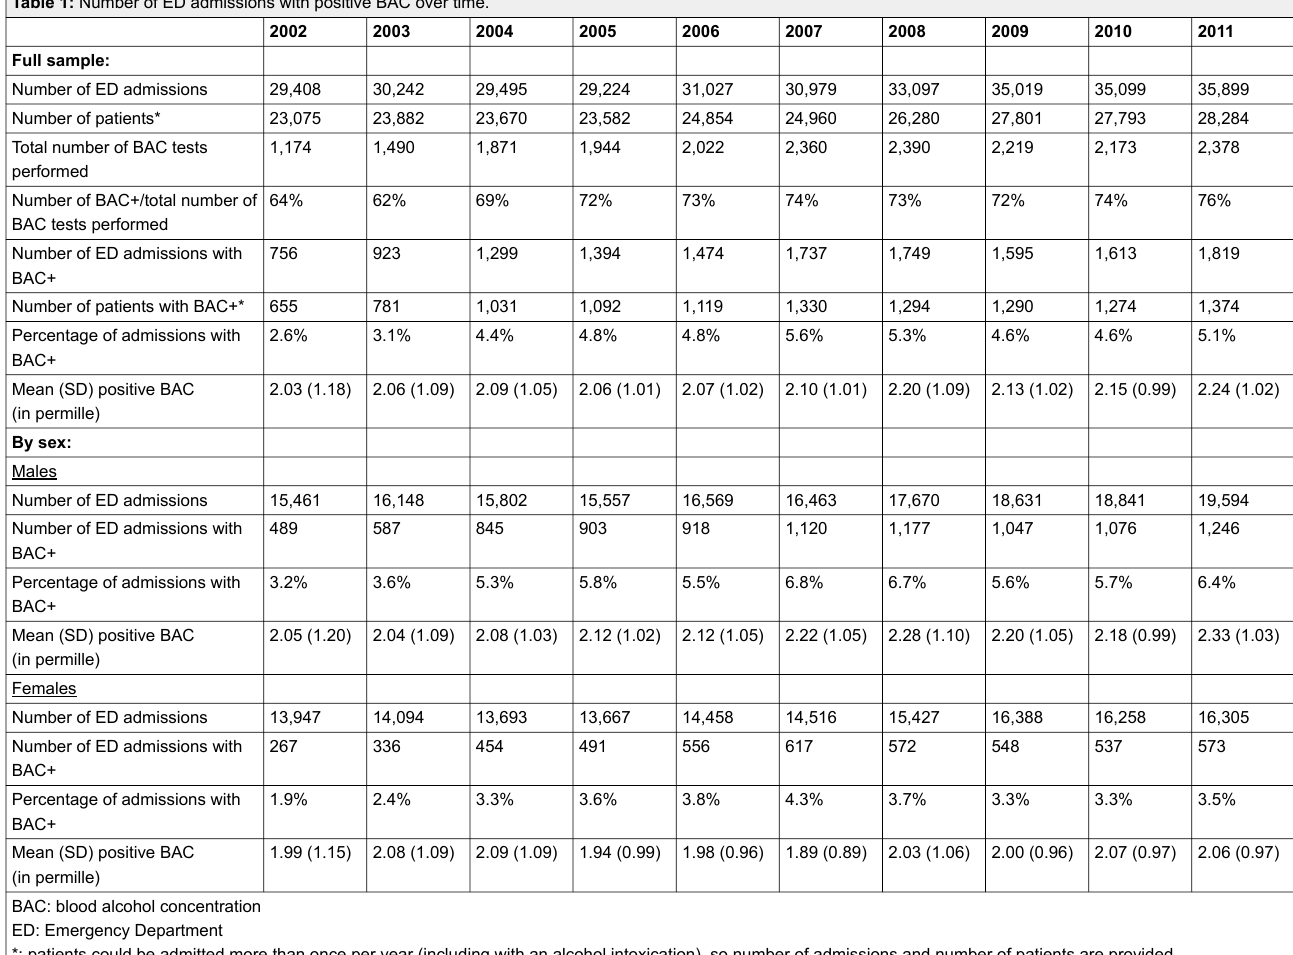
Table 1: Number of ED admissions with positive BAC over time.